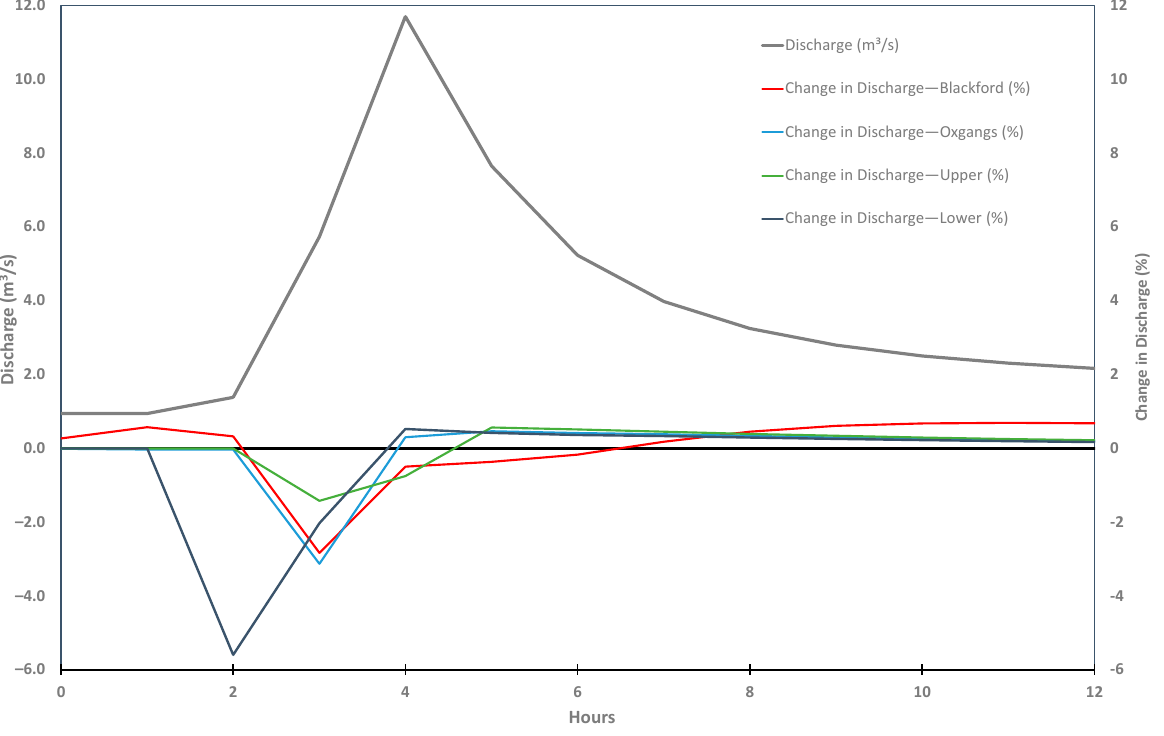
Figure 6. Baseline outlet discharge flow and change in discharge for each incorporated pond for a 1 in 100 year 1 h event starting at hour 0. This is for the standard storage. The plot of the change in discharge against the baseline discharge can be seen in Figure 7. In Figure 7b, for the standard storage, the data are the same as for Figure 6, again showing that for the highest baseline discharge (11.7 m 3 /s), the Blackford ( − 0.51%) and Upper ( − 0.77%) ponds reduce the discharge, but the Lower (+0.51%) and Oxgangs (+0.26%) ponds increase the discharge. For the increased storage in Figure 7a, the Upper ( − 1.4%) pond easily produces the best reduction in storage, with the Blackford ( − 0.54%) and Oxgangs ( − 0.22%) ponds also reducing the discharge, and the Lower pond increasing the discharge (+0.30%). For the reduced storage in Figure 7c, the Blackford ( − 0.28%) pond produces the best reduction in storage, with the Upper ( − 0.13%) pond slightly reducing the discharge, whereas the Oxgangs (+0.31%) and the Lower ponds increase the discharge (+0.42%).